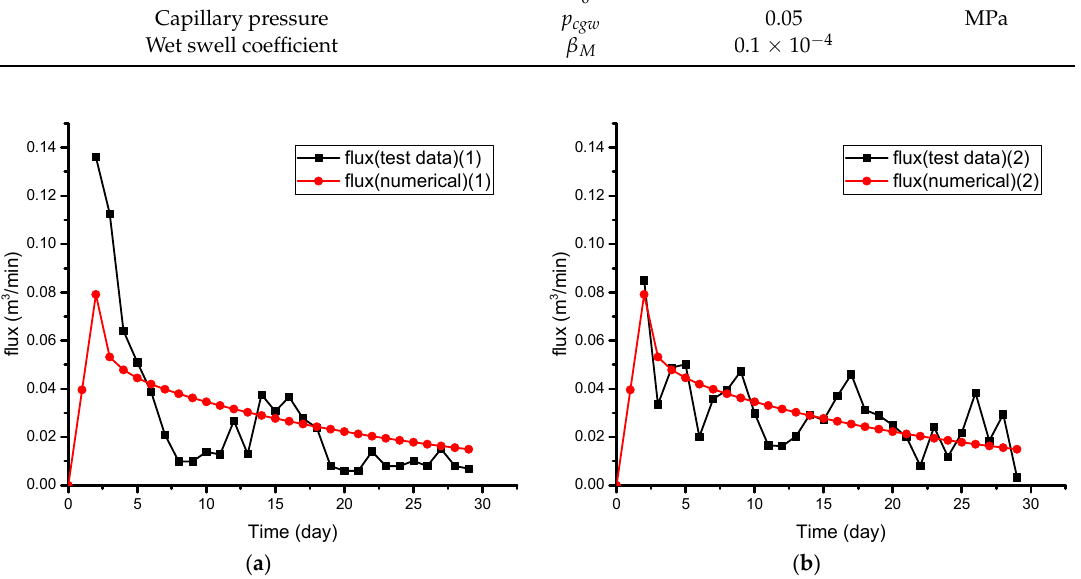
Figure 2. ( a ) Geometrical models of the coal seam, rock strata, and borehole; ( b ) geometrical models of the coal seam and the borehole.